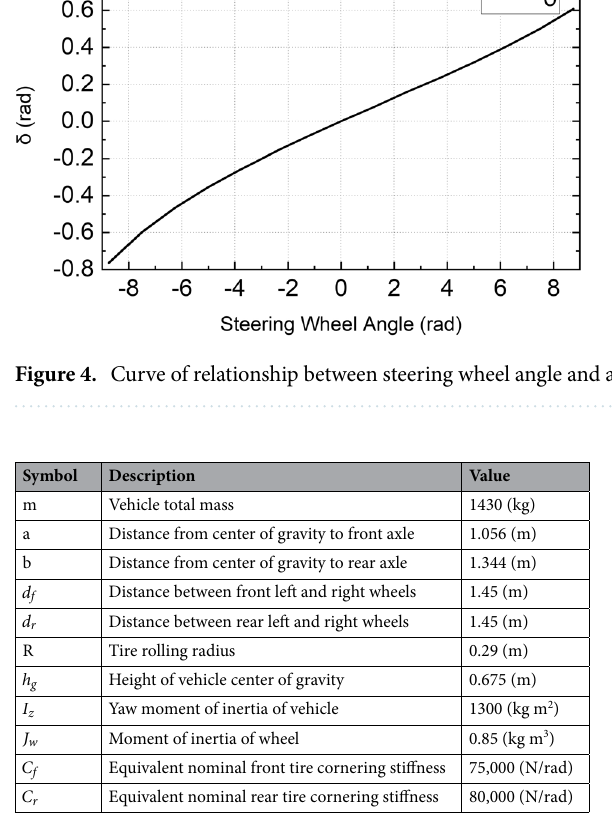
Table 1. Main DDAV